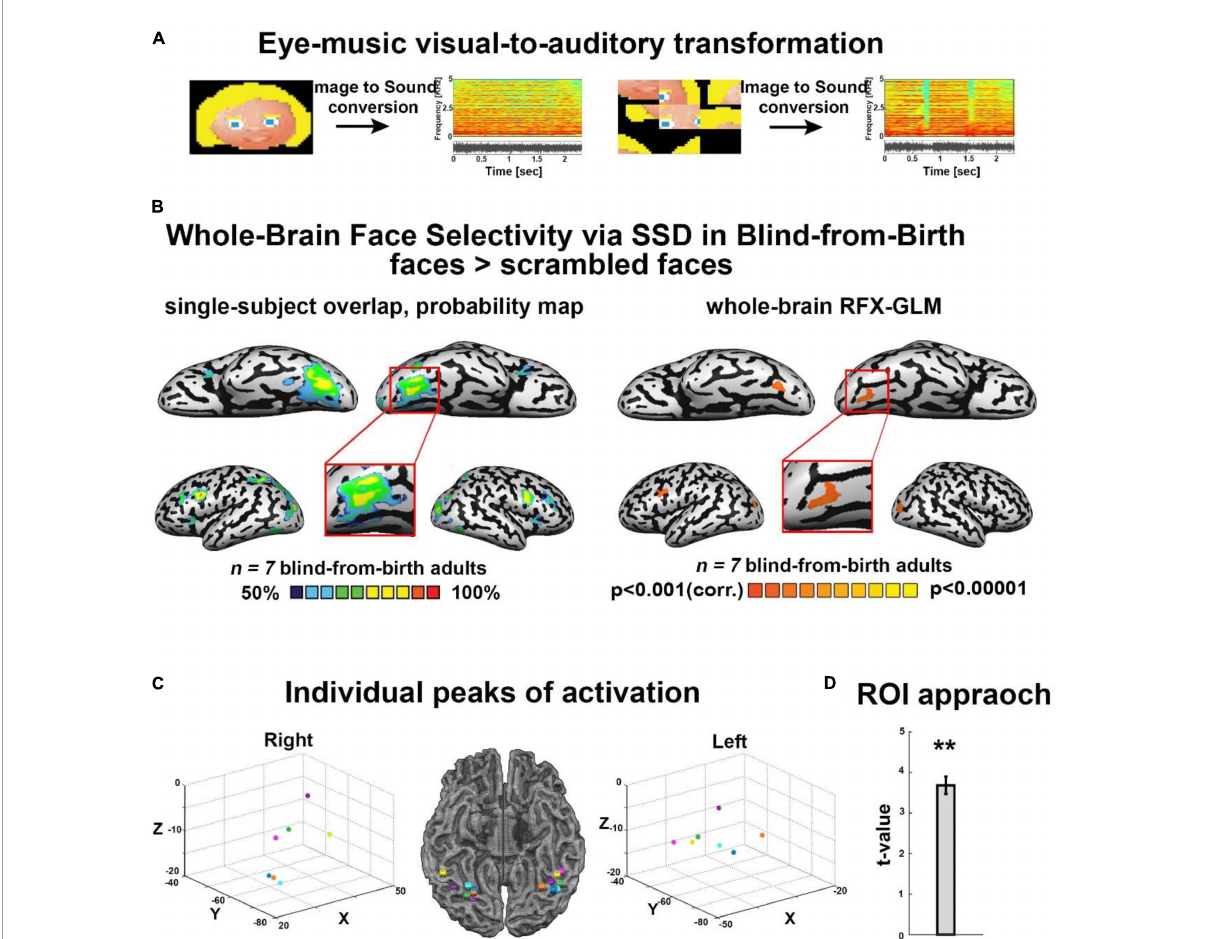
FIGURE1 (A) Examples of some of the visual stimuli used, with their corresponding spectrograms after sonification via the Eye-Music visual-to-auditory SSD for trained and scrambled faces. (B) Trained faces > scrambled faces. Left: RFX-general linear model (GLM) analysis showed a bilateral cluster in fusiform gyrus (FG) (Talairach coordinates: right: 19, –68, –13 (zoom); left: –34, –65, –14). We also found bilateral clusters of activation in a region within the middle occipital gyrus, including the location of occipital face area (OFA) as described in the sighted (Talairach coordinates: right: 21, –94, –5; left: –33, –82, –8) and a cluster of activation in the left inferior frontal gyrus (IFG, Talairach coordinates: –45, 8, 31), two other cortical regions known to be involved in face processing. No preference for faces was observed in the auditory cortex (top panel). Right: The probability map obtained from the overlap of single participants’ activations for the same contrast reveals a remarkably consistent face preference in FG. (C) Trained faces > Scrambled faces. Individual peaks of activation in bilateral FG for all participants are located around the canonical location of the fusiform face area (FFA) in the sighted, lateral to the mid-fusiform sulcus. (D) Region of interest (ROI) approach: significant preference for trained faces > scrambled faces within the canonical location of the sighted right FFA. ** P <